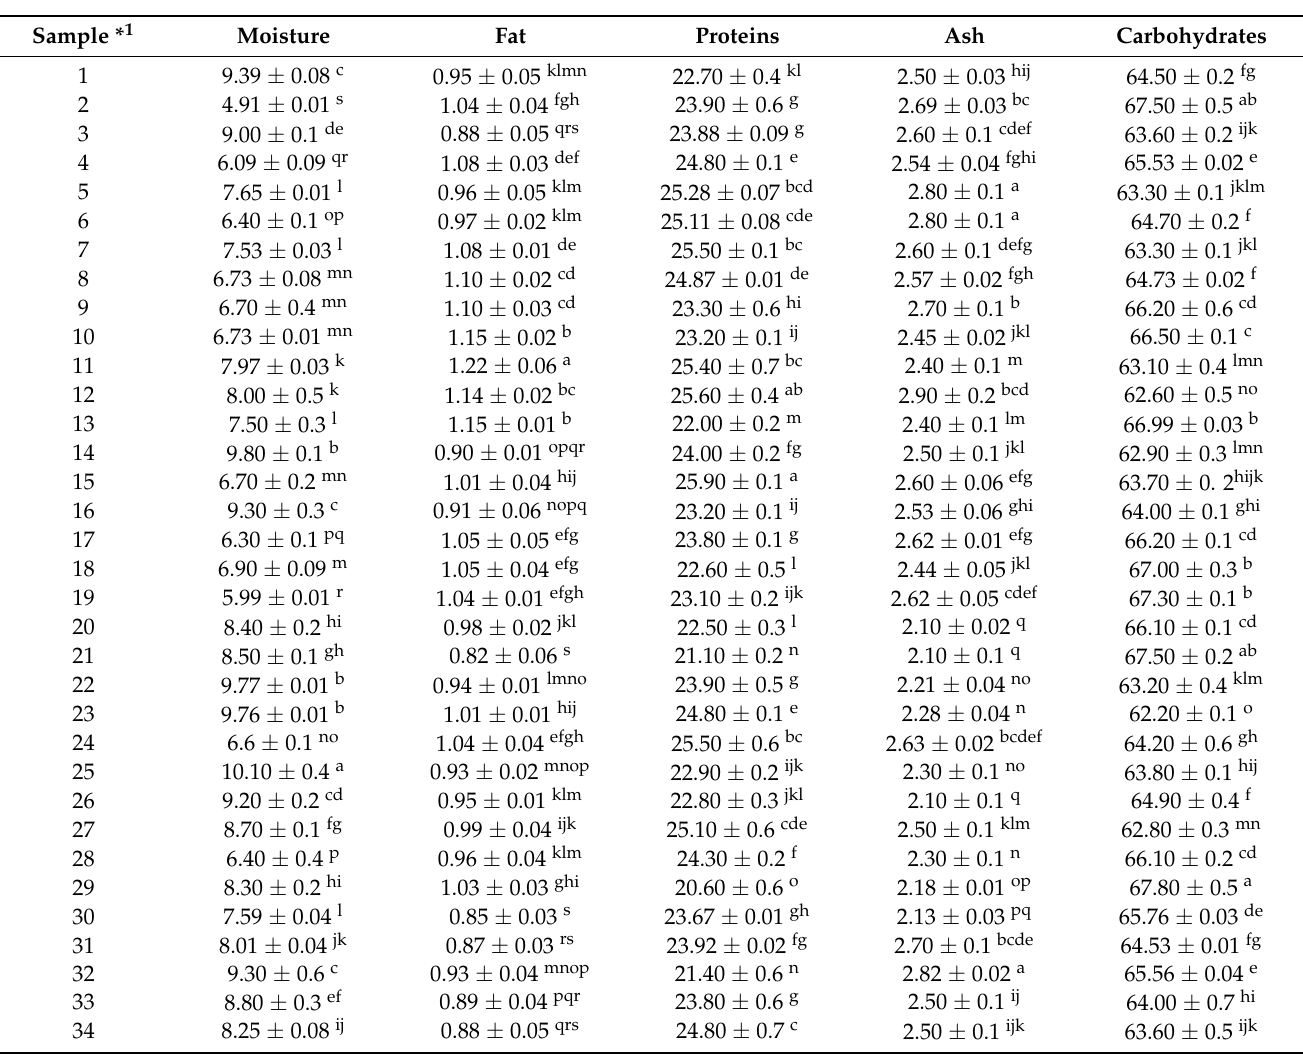
Table 1. Nutritional value (g/100 g fw) and energetic value (kcal/100 g fw) of the studied Pardina lentil “Lenteja de Tierra de Campos” (mean ± SD, n =